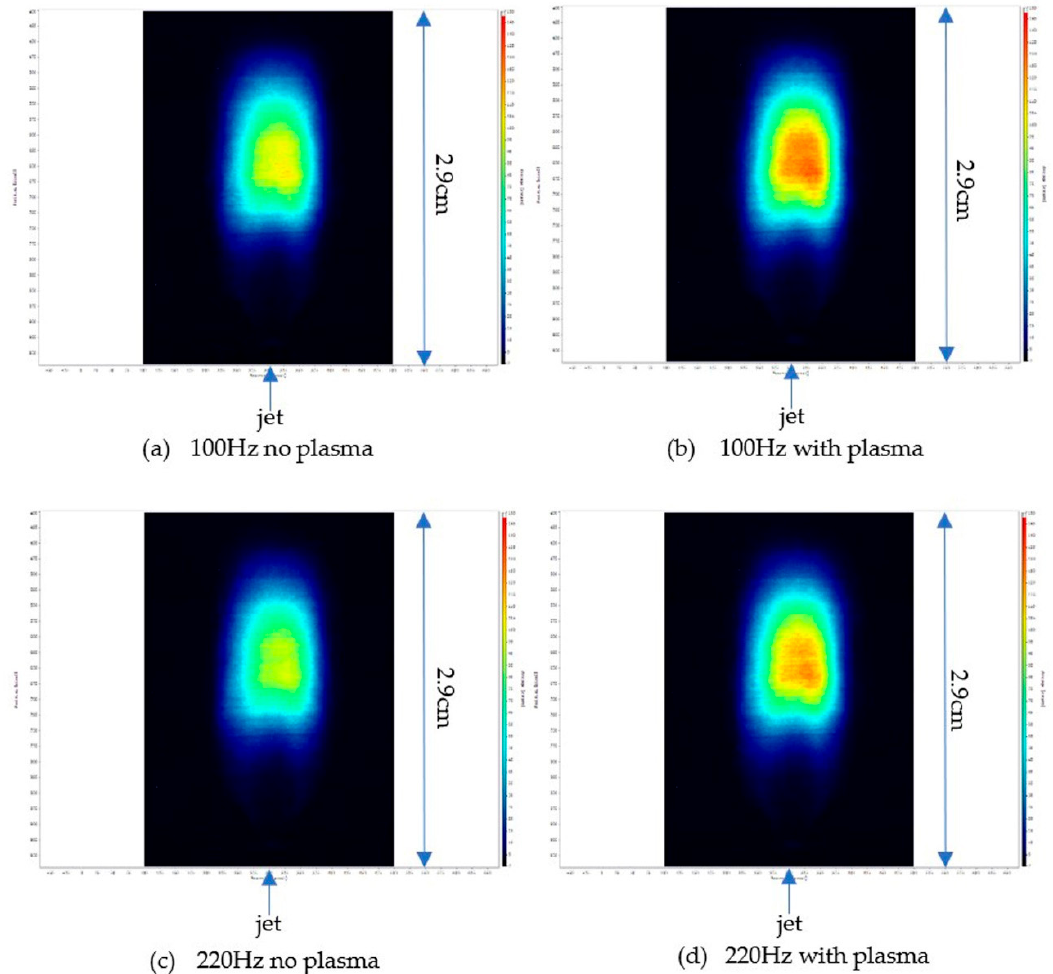
Figure 8. The effects of plasma on the spatial distribution of OH radicals.